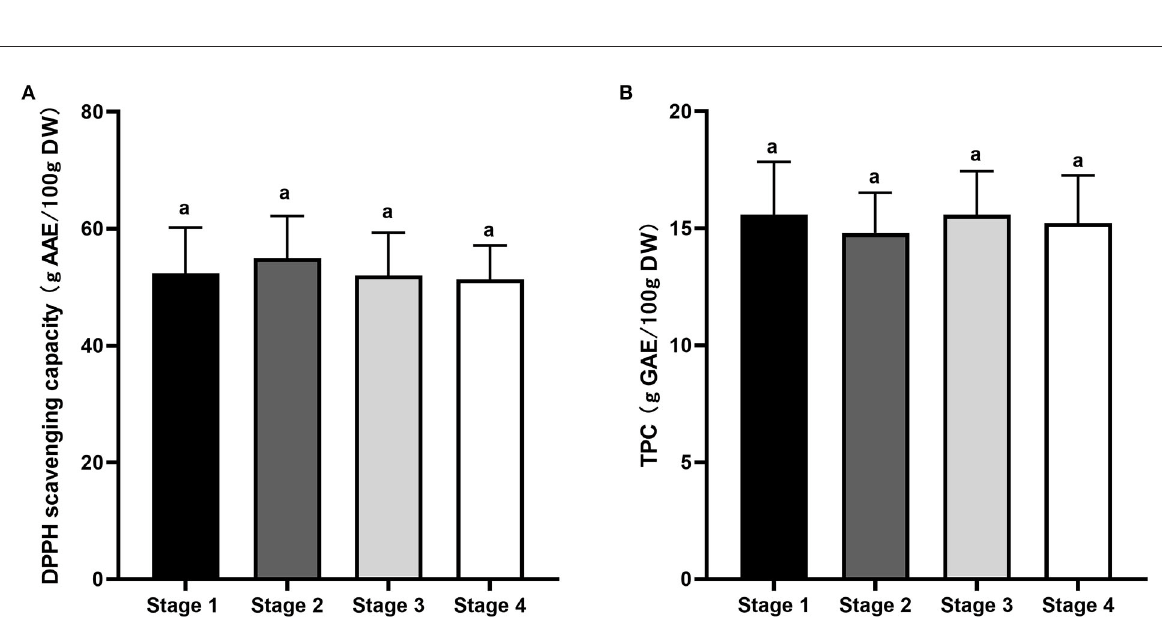
FIGURE6 (A) DPPH-free radical-scavenging capacity and (B) total phenolic content of Kakadu plum fruit at different maturity stages. Data are mean ± SE ( n = 6). DPPH-scavenging activity and TPC are expressed as ascorbic acid equivalent (g AAE/100g DW) and gallic acid equivalent per 100g dry sample (g GAE/100g DW), respectively. Different letters indicate the significant differences at p ≤